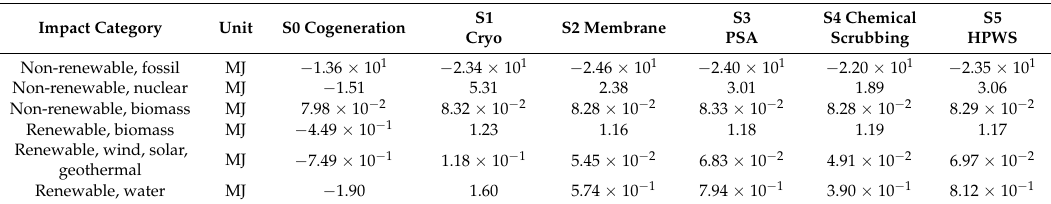
Table 5. Cumulative Energy Demand (CED) characterized impacts calculated through the avoided burden approach for different conversion routes of biogas, with reference to a functional unit of 1 m 3 of used